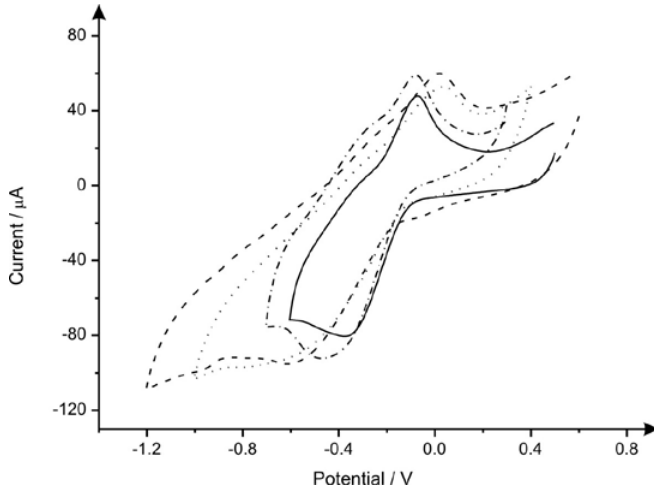
Figure 2. Typical cyclic voltammograms recorded with 1 mM hexaammineruthenium(III) chloride/0.1 M KCl using PDE1 (HB pencil, Box 1) drawn 15 (dotted line), 30 (dashed line), 60 (solid line) and 100 (dashed dotted line) times. Scan rate: 50 mV·s − 1 .